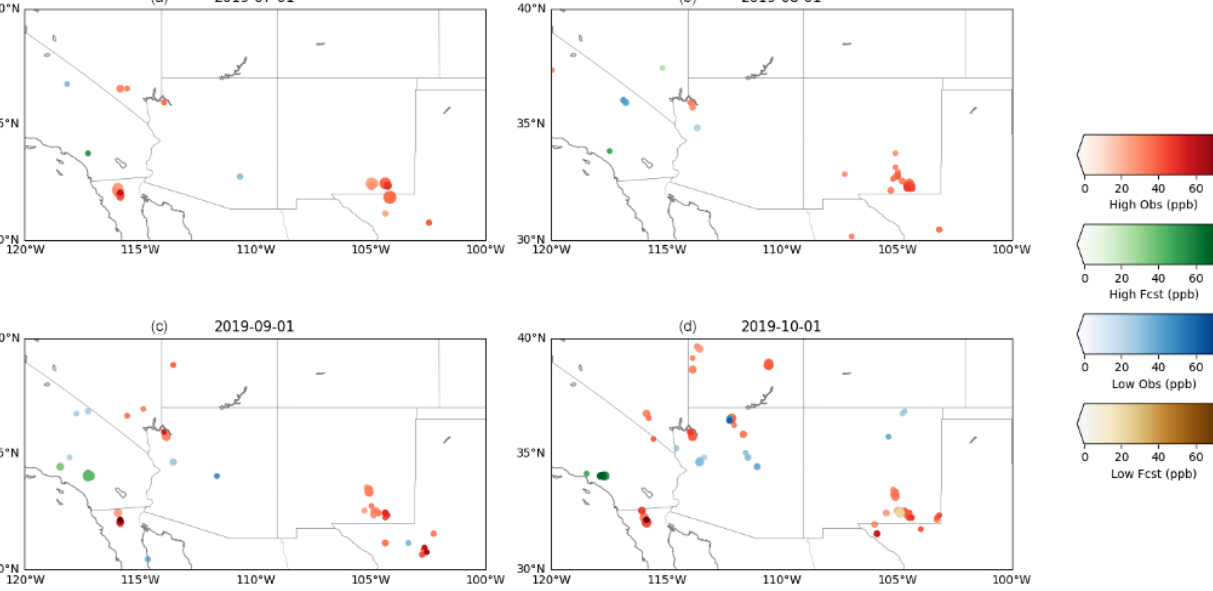
Figure 10. Outlier detection and classification over the southwestern USA. Dates indicate the end date of the 30d time